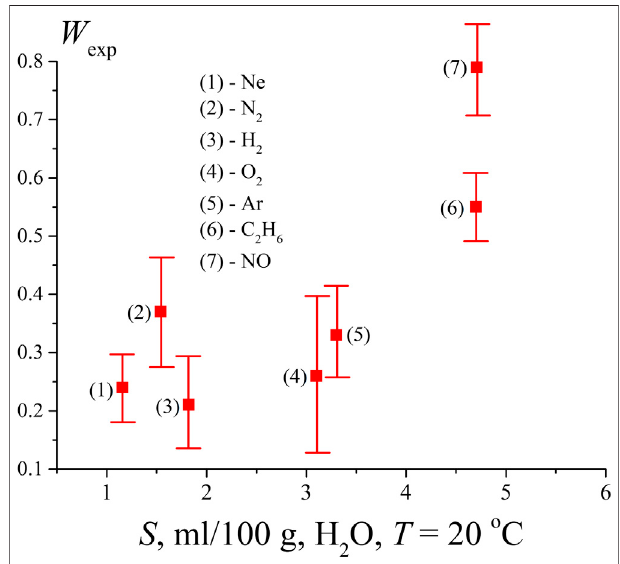
FIGURE 4 | Probability W exp , measured after saturation of the water sample by gases of various solubility (ml/100 g).